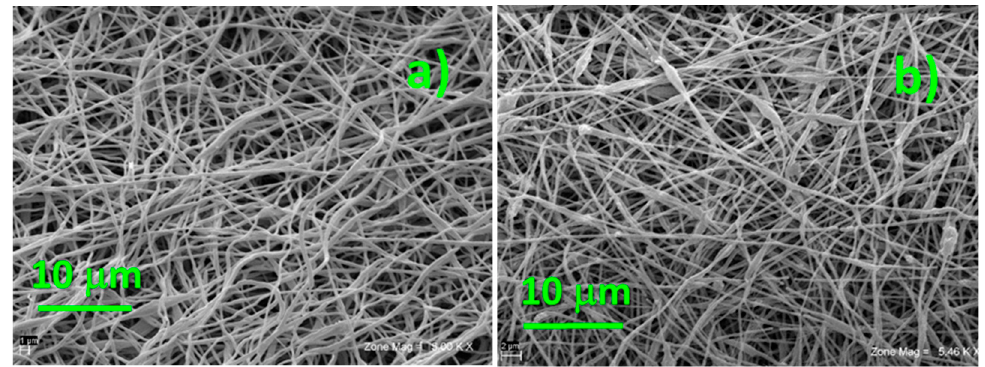
Figure 1. SEM images of the two electrospun membranes: ( a ) without silica additive, and ( b ) with 10 wt.% SiO 2 .